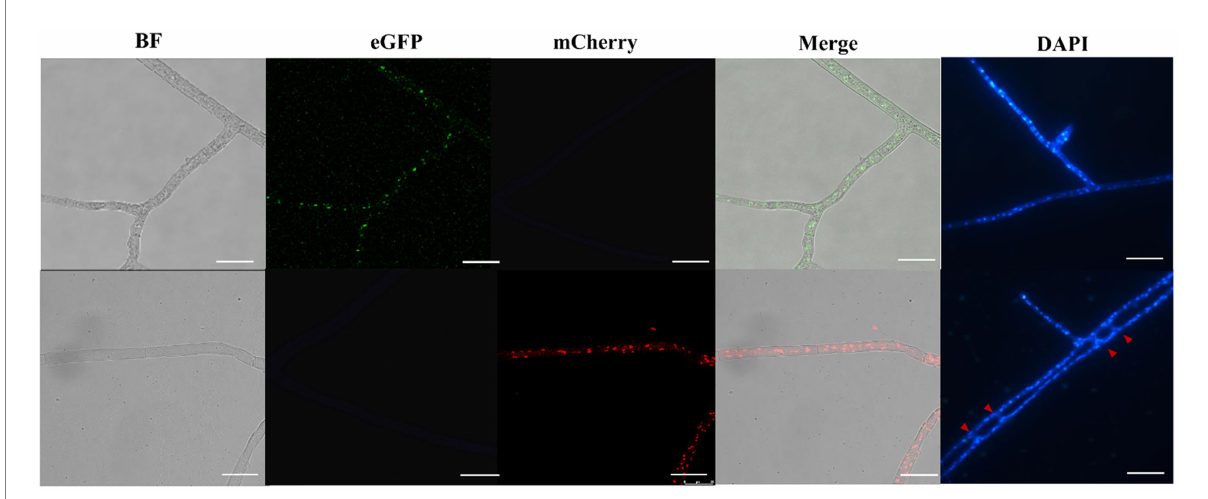
FIGURE 2 Fluorescence microscopic observation of M. importuna transformants. Green (H2B-eGFP) or red (H2B-mCherry) dots indicate the location of nuclei. DAPI-stained nuclei supported the corrected expression of H2B-FP, and red arrows point to vegetative fusion of two adjacent hyphae. BF, bright field; Merge, tricolor overlapping of BF, eGFP, and mCherry. Bar = 25 μ